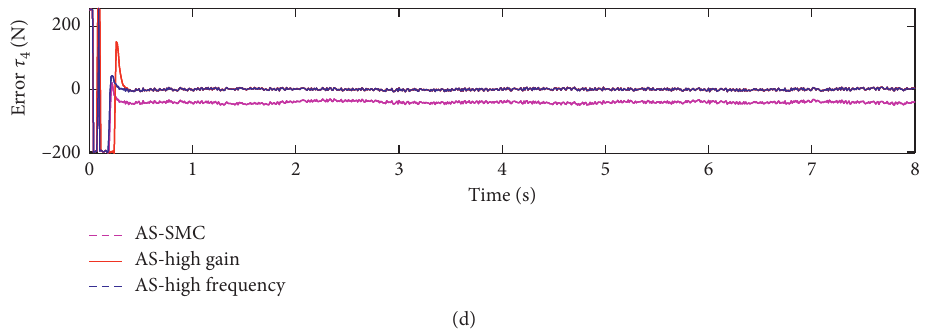
Figure 13: The force errors of actuator joints.